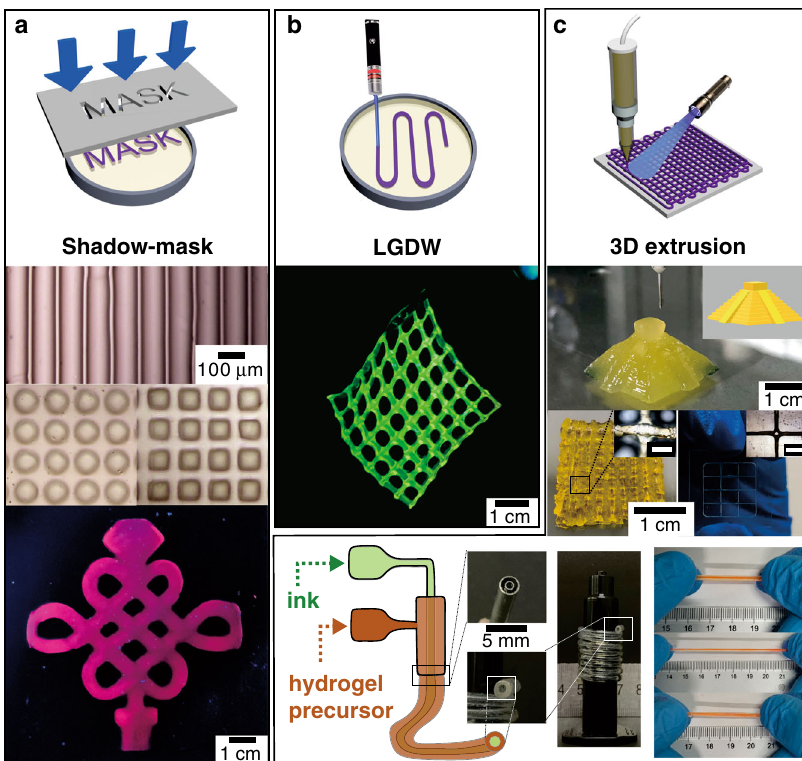
Fig. 4 Designing THVMD patterns and 3D structures using typical printing techniques. a Shadow-mask lithography: Lines, balls, squares and Chinese knot. b Laser-guided direct printing: FITC-labelled mesh. The irradiation intensity = 200 mWcm − 2 , scanning rate = 90 mm s − 1 . c 3D extrusion printing: The pyramid-shape hydrogel, porous skeleton, grid (5 layers), and tough hydrogel tubes. The red solution in tubes is the ethylene glycol solution of Eosin Y. Both Eu-contained Chinese knots in a and FITC-labelled mesh in b fl uoresce under UV irradiation (~365 nm). The thickness of samples in a , b is 2 mm. The scale bars in c are 1